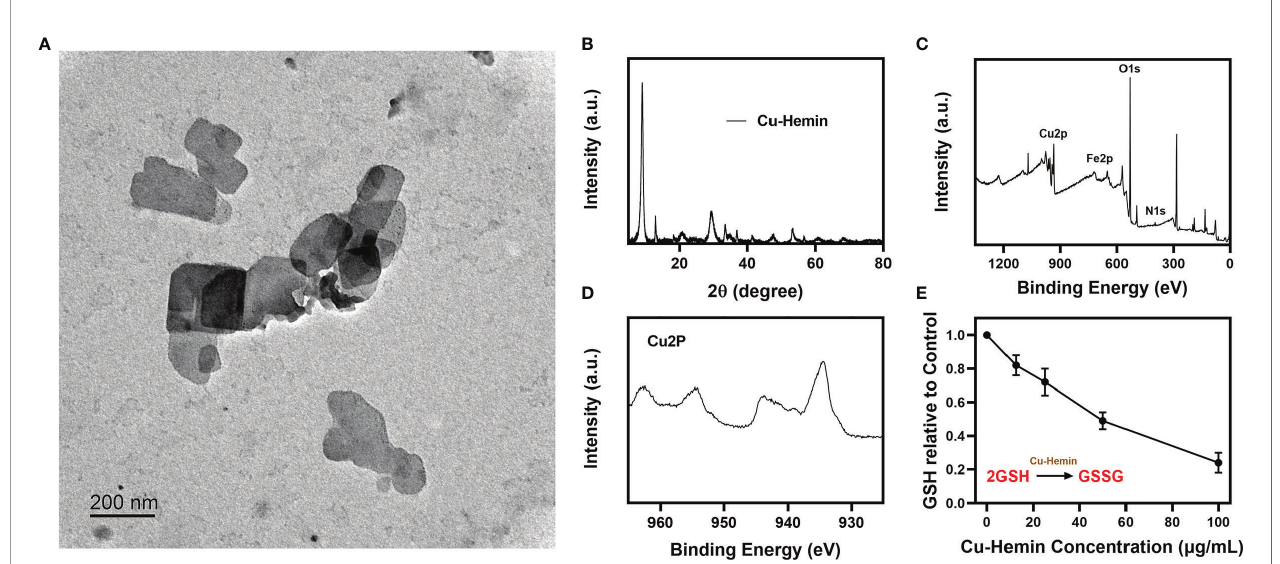
FIGURE 1 | Characterization analysis of Cu-Hemin. (A) TEM image of Cu-Hemin nanosheets. (B) XRD pattern of Cu-Hemin. (C) The XPS spectrum of Cu-Hemin. (D) The Cu 2p XPS spectra of Cu-Hemin nanosheets. (E) The relative GSH content of the supernatant after the reaction of various concentrations Cu-hemin and 10 mm GSH in mixed solution for 24